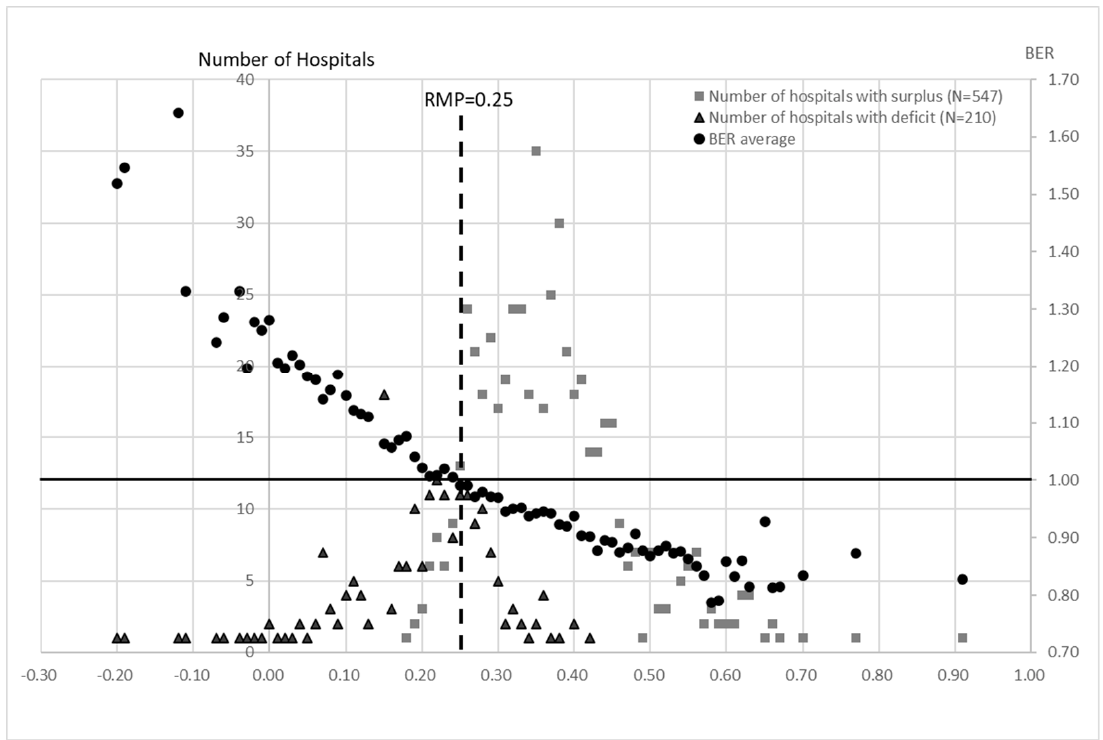
Figure 8. Calculation of BER for each RMP in groups 1, 2, and 3 for all 15 years. The BER shows the average of all hospitals with each RMP value. The number of deficit and surplus hospitals for all years was disaggregated by the RMP value. Most surplus hospitals were located above RMP = 0.25, while most deficit hospitals were located below 0.25. On the other hand, the average BER crosses the line of RMP = 0.25 between surplus and deficit hospitals. This indicates that RMP = 0.25 is a critical point in terms of management.